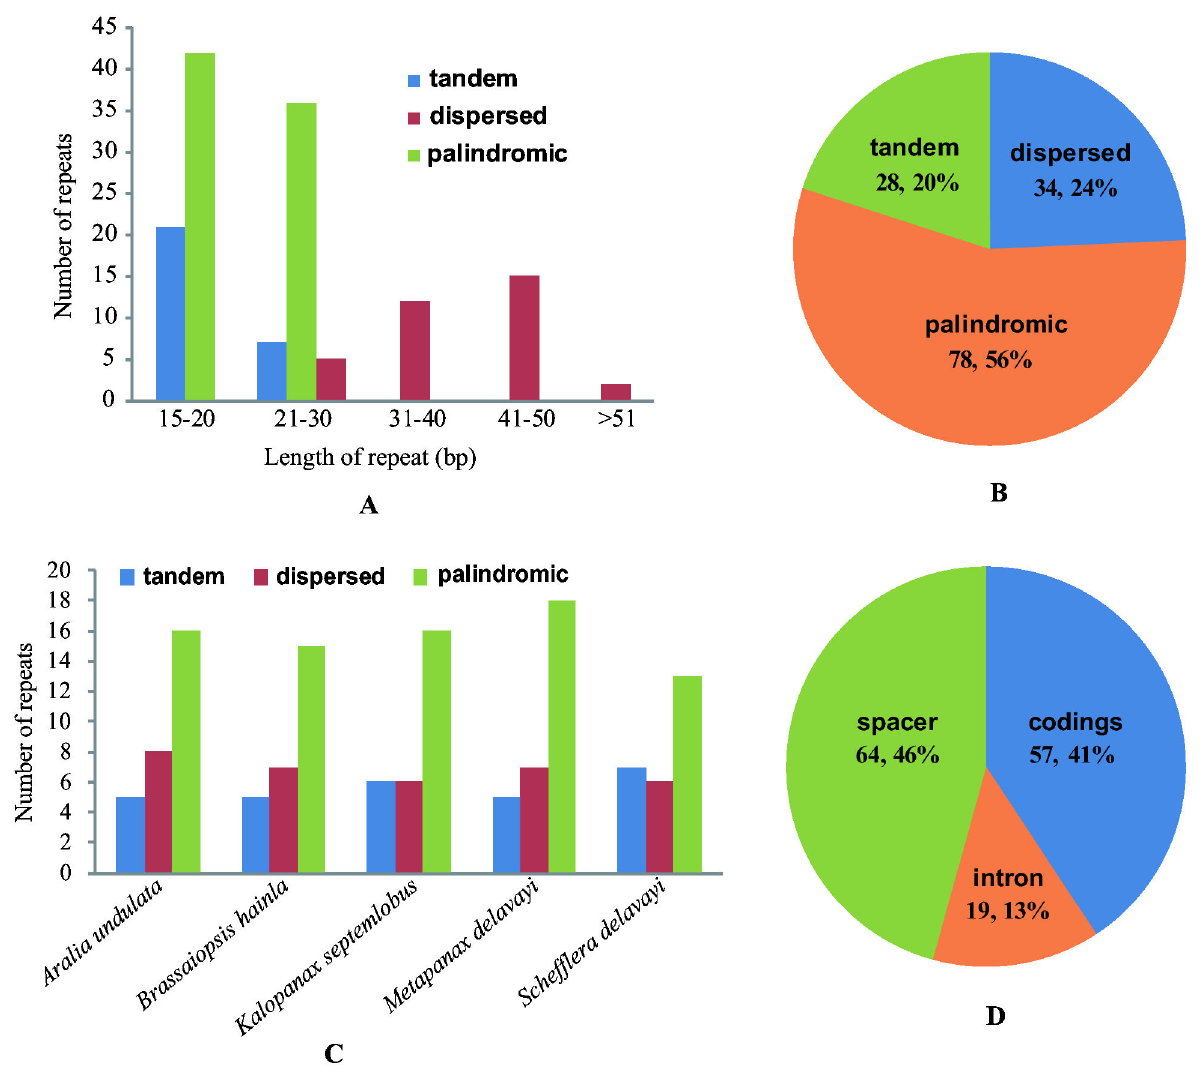
Figure 4. Repeat structure analysis in the five Araliaceae chloroplast genomes. A: Histogram showing the frequency of repeats by length in the five Araliaceae chloroplast genomes; B: Composition of the 140 repeats from five Araliaceae species; C: Histogram showing the number of three repeat types in each Araliaceae chloroplast genome; D: Location of the 140 repeats from five Araliaceae